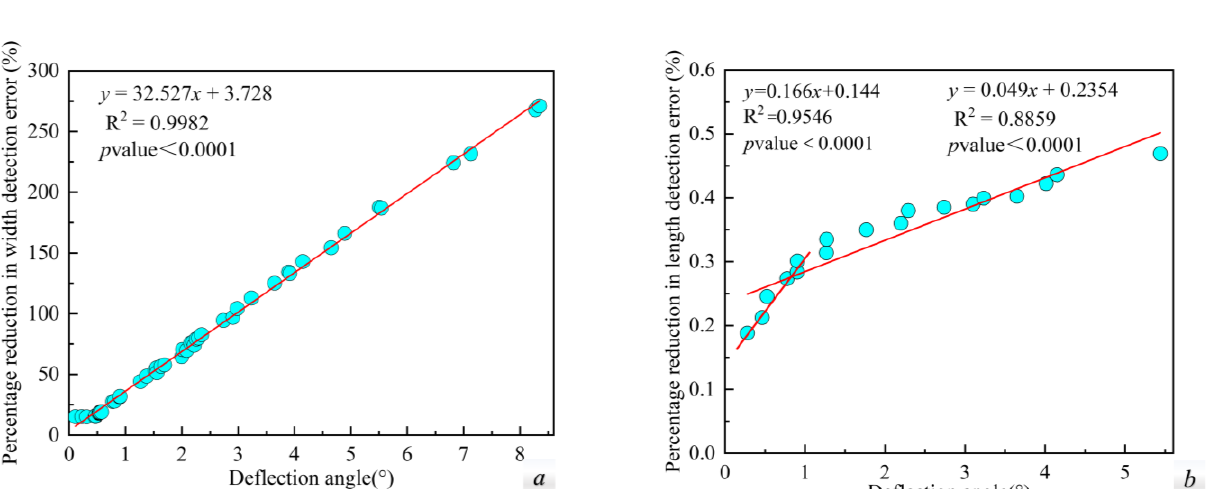
Figure 10. Percentage reduction in error of the dimensional measurement (%). ( a ) Percentage reduction in error of the width measurement (%). ( b ) Percentage reduction in error of the